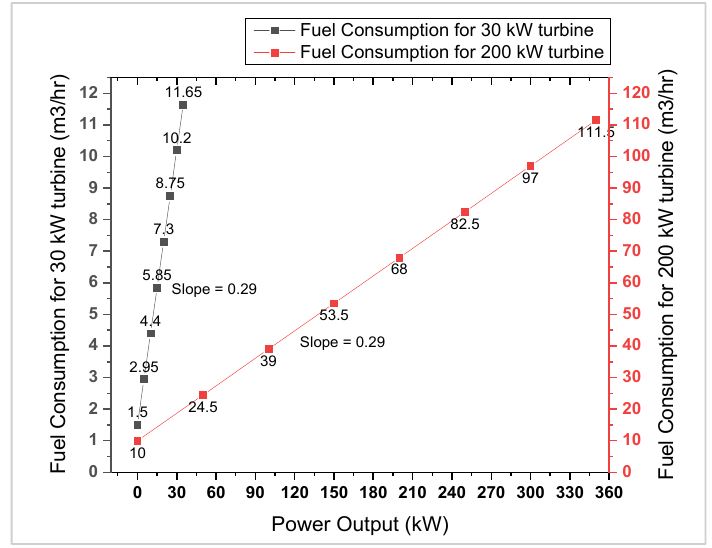
Figure 4. Fuel consumption curves for 30 kW and 200 kW gas microturbines.